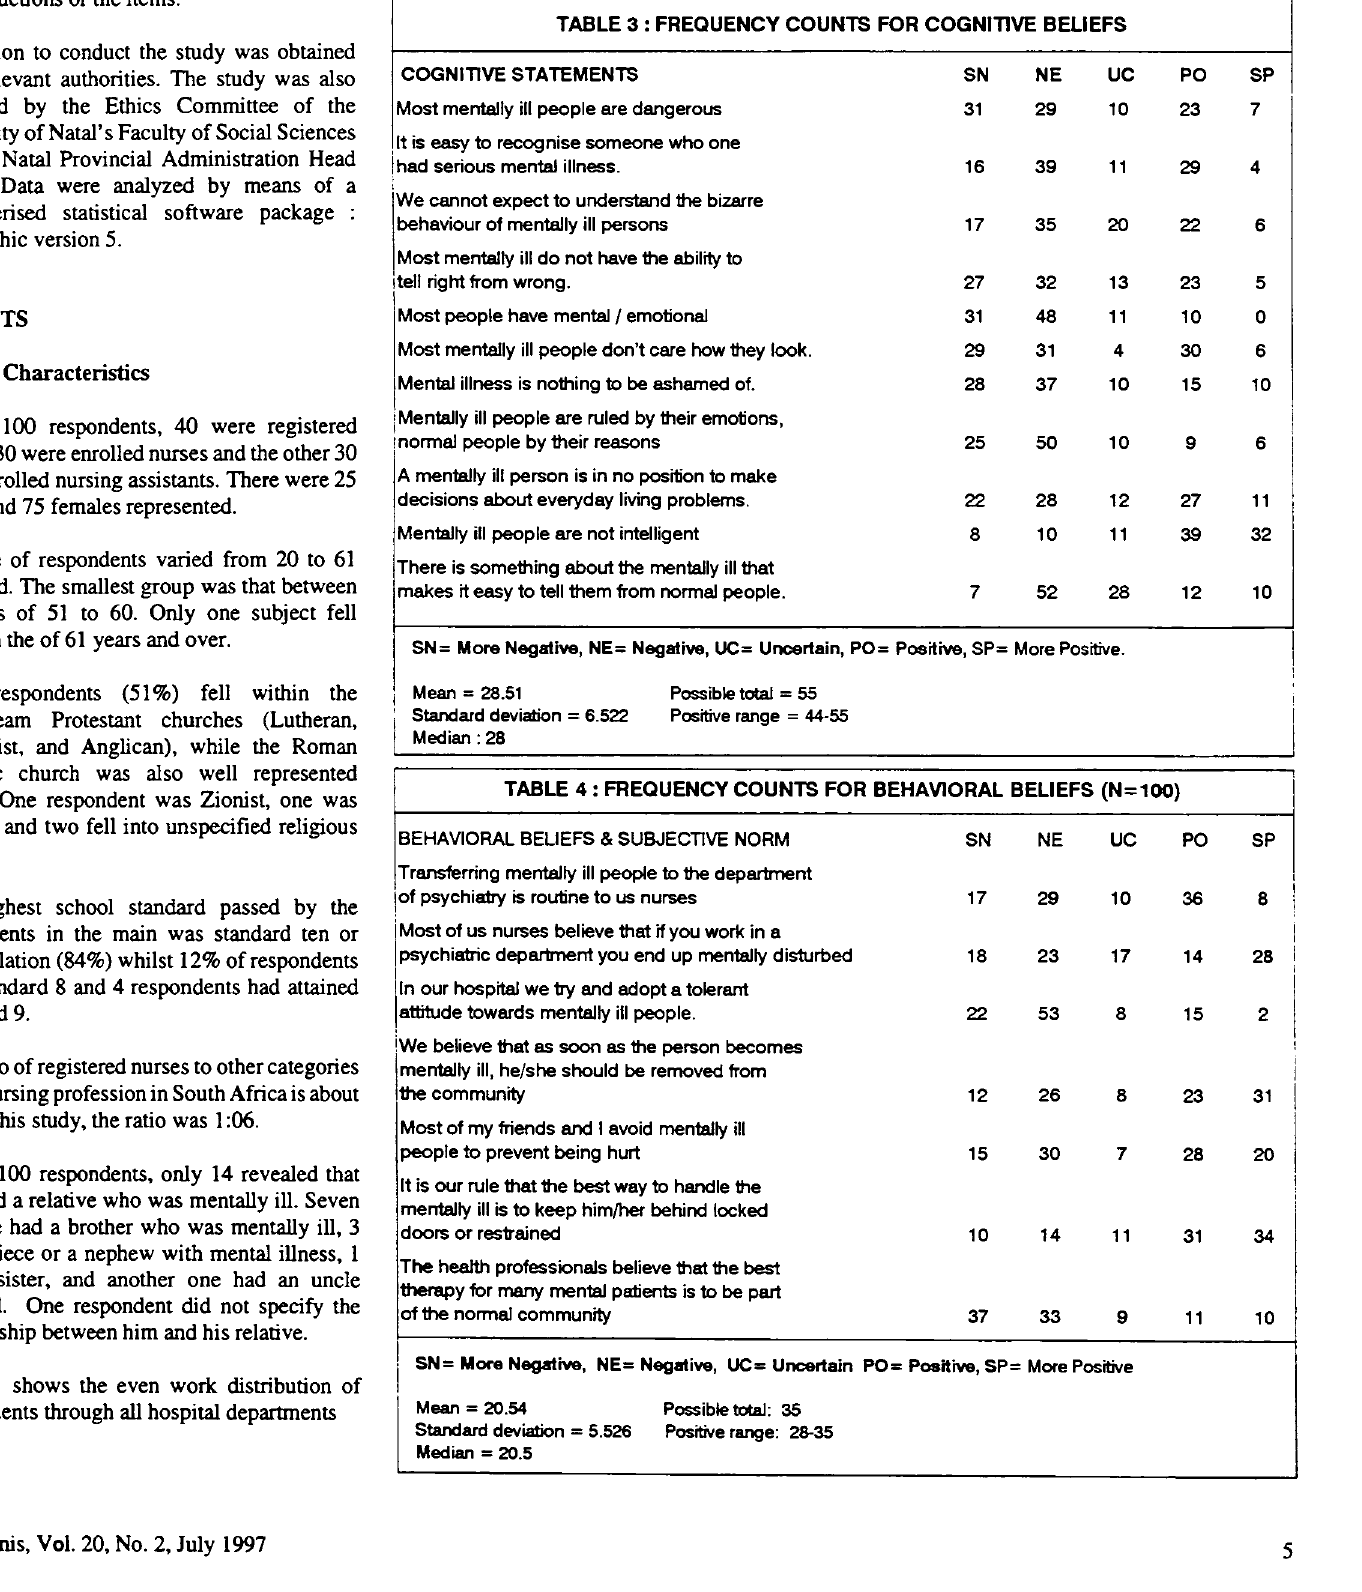
TABLE 3 : FREQUENCY COUNTS FOR COGNITIVE BELIEFS